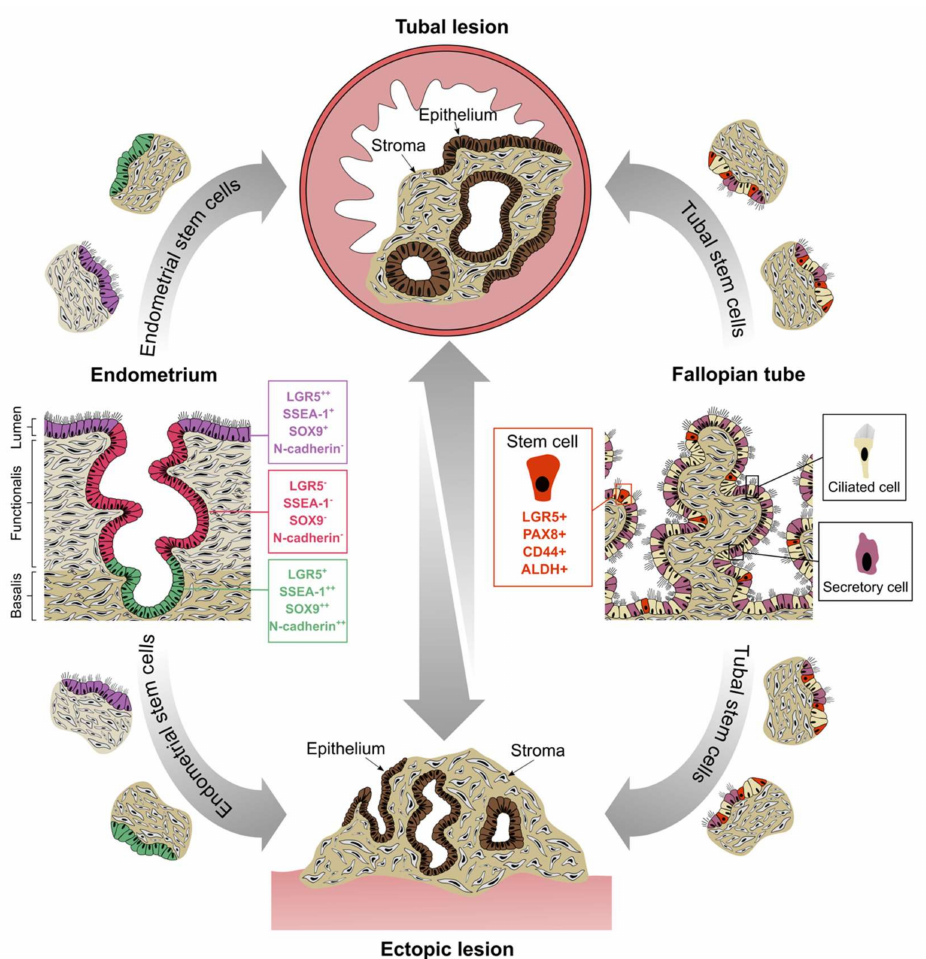
Figure 4. Schematic illustration of the proposed stem cell origins of tubal and pelvic endometriosis. Putative stem cell niches exist in the endometrial basalis (LGR5 + , SSEA-1 ++ , SOX9 ++ and N-cadherin ++ ), lumen (LGR5 ++ , SSEA-1 + and SOX9 + ) and FT epithelium (LGR5 + , PAX8 + , CD44 + and ALDH + ). Endometrial fragments containing stem cells may be refluxed into the peritoneal cavity via the tubes, giving rise to both tubal and pelvic endometriosis. Analogously, desquamation of the endosalpinx through injury or natural shedding may also deposit fragments within the tubal lumen and out into the peritoneal space, thus establishing endometriotic explants of tubal origin. Once established, lesions arising from either the endometrium or the FT can spread to secondary